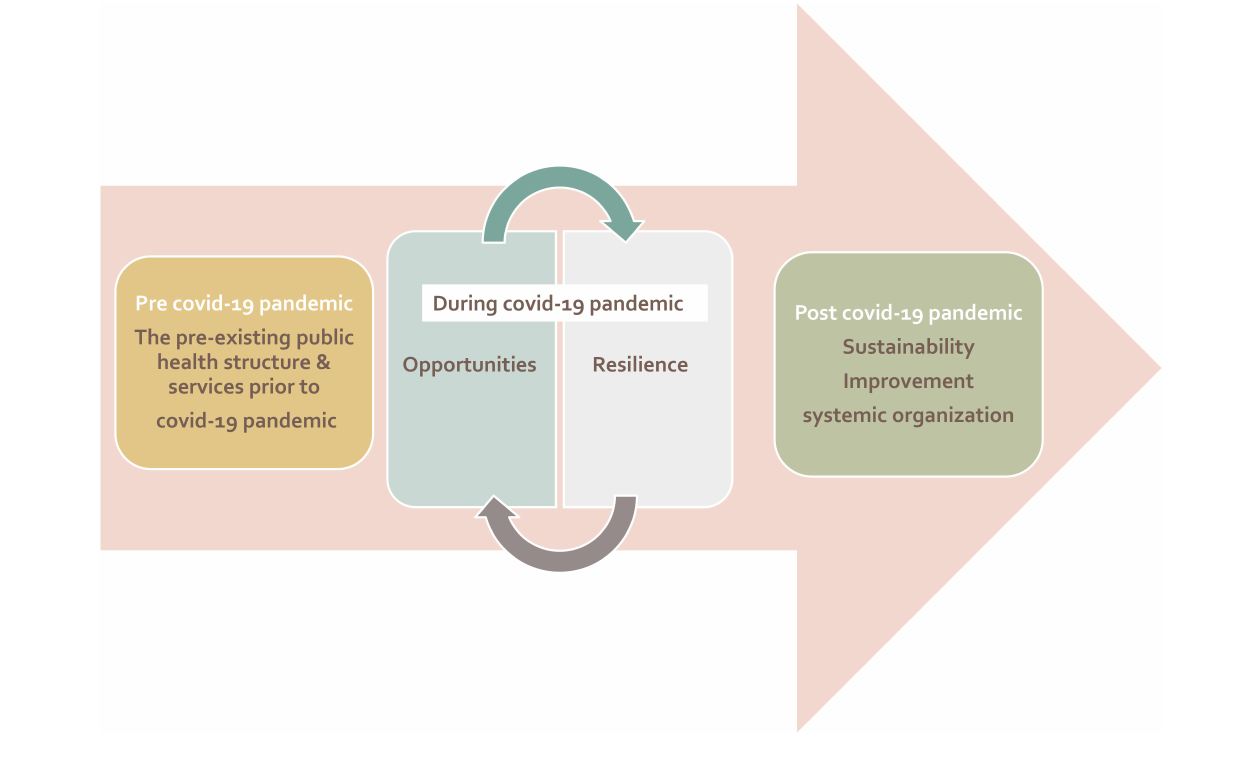
FIGURE 1 | Framework scheme of the review.